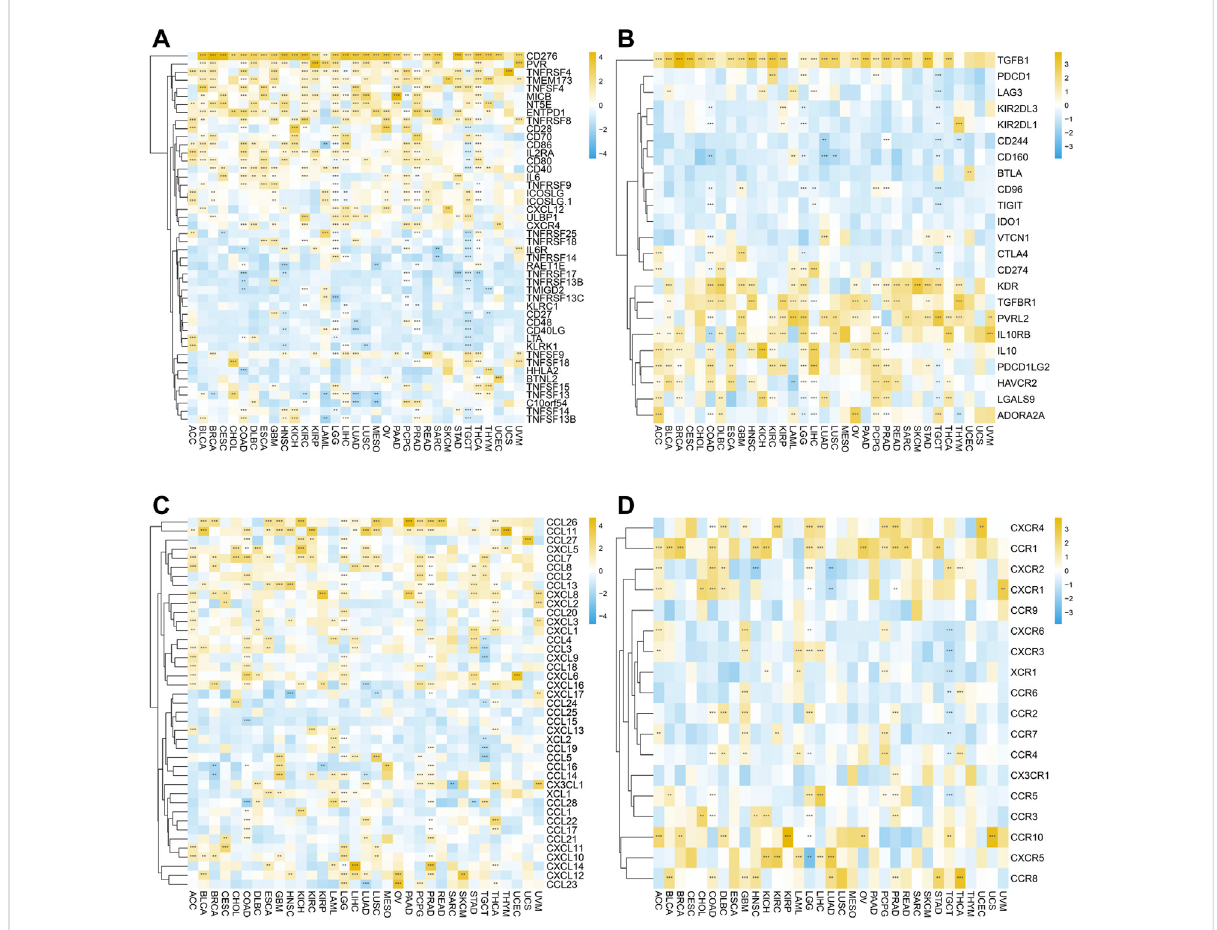
FIGURE 11 Correlation between SERPINH1 expression and immune regulation – related genes as well as chemokines. These heatmaps, respectively, indicate the correlation between the expression of SERPINH1 and immune activation genes (A) , immunosuppressive state-related genes (B) , chemokine genes (C) , and chemokine receptor genes (D) . * p < 0.05; ** p < 0.01; *** p < 0.001, and **** p <